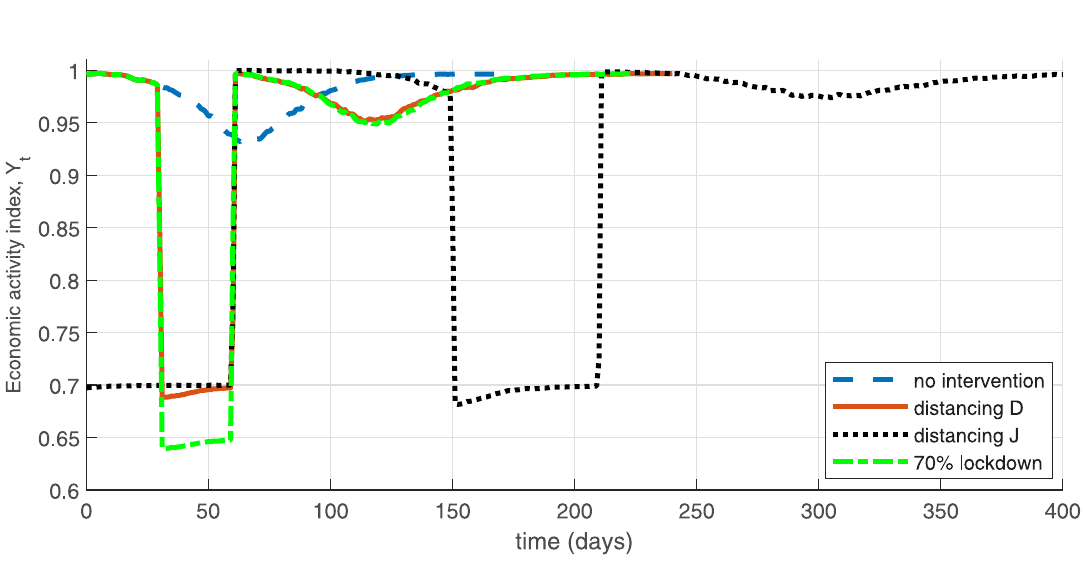
Fig 12. Economic impact illustration—NSIR